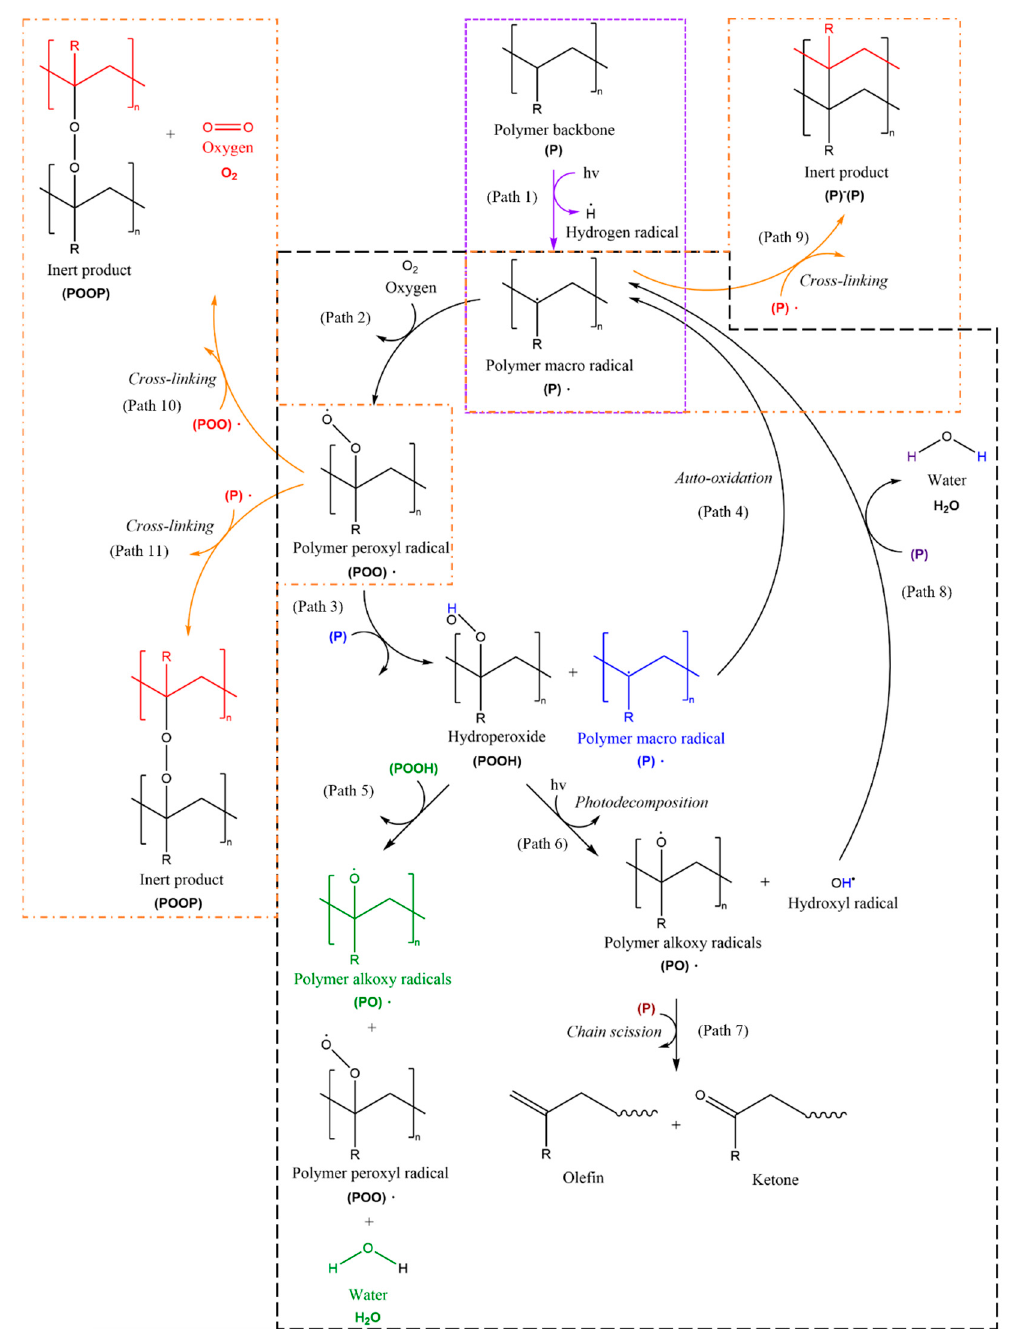
Figure 3. Photodegradation mechanism of polymer involving free radical oxidation. Purple dotted box: Initiation step; black dashed boxes: Propagation step; orange dash-dotted boxes: Termination step.